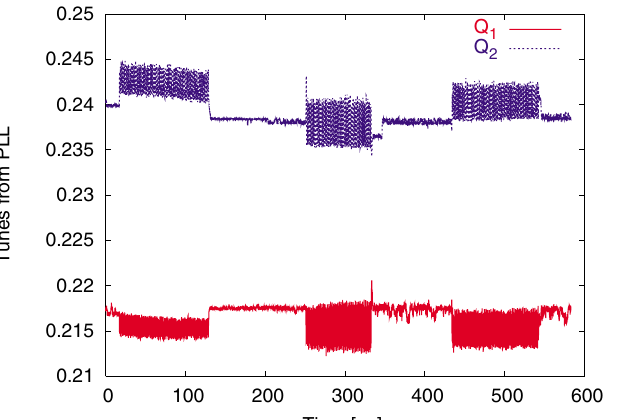
FIG. 3. (Color) FFT spectrum of j (cid:4) Q j 2 for Fig. 2 tune